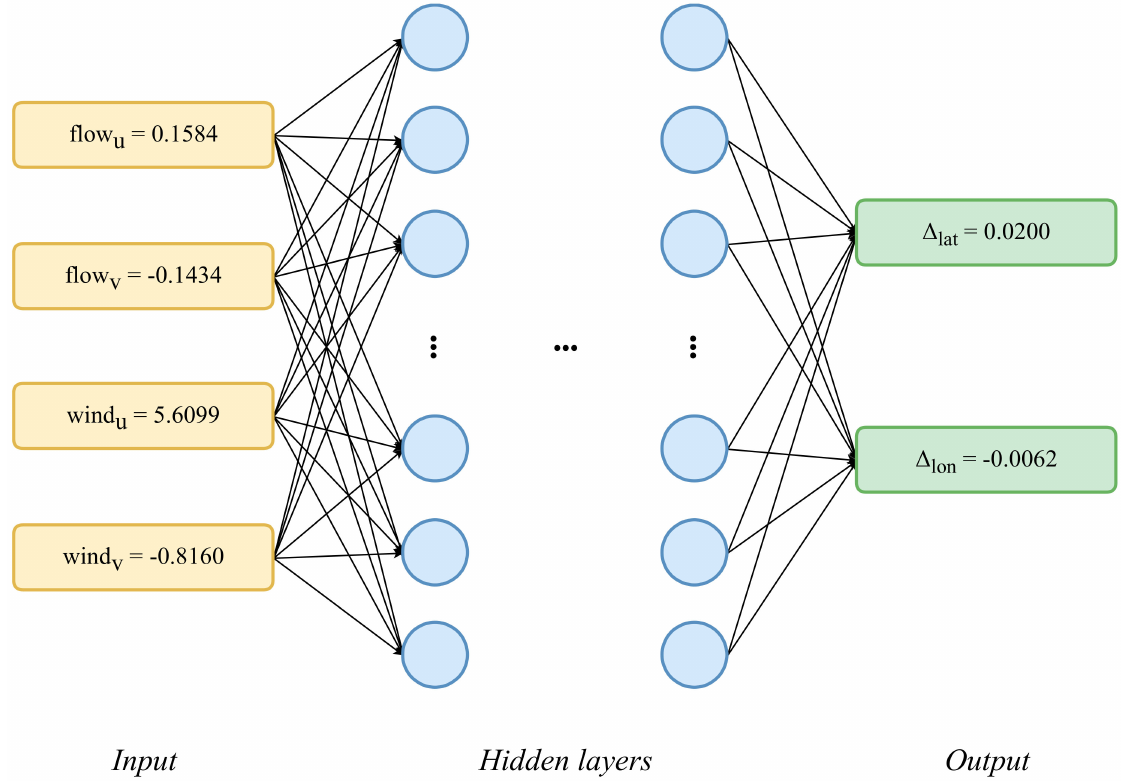
Figure 2. Data input / output in our deep neural network (DNN) model.